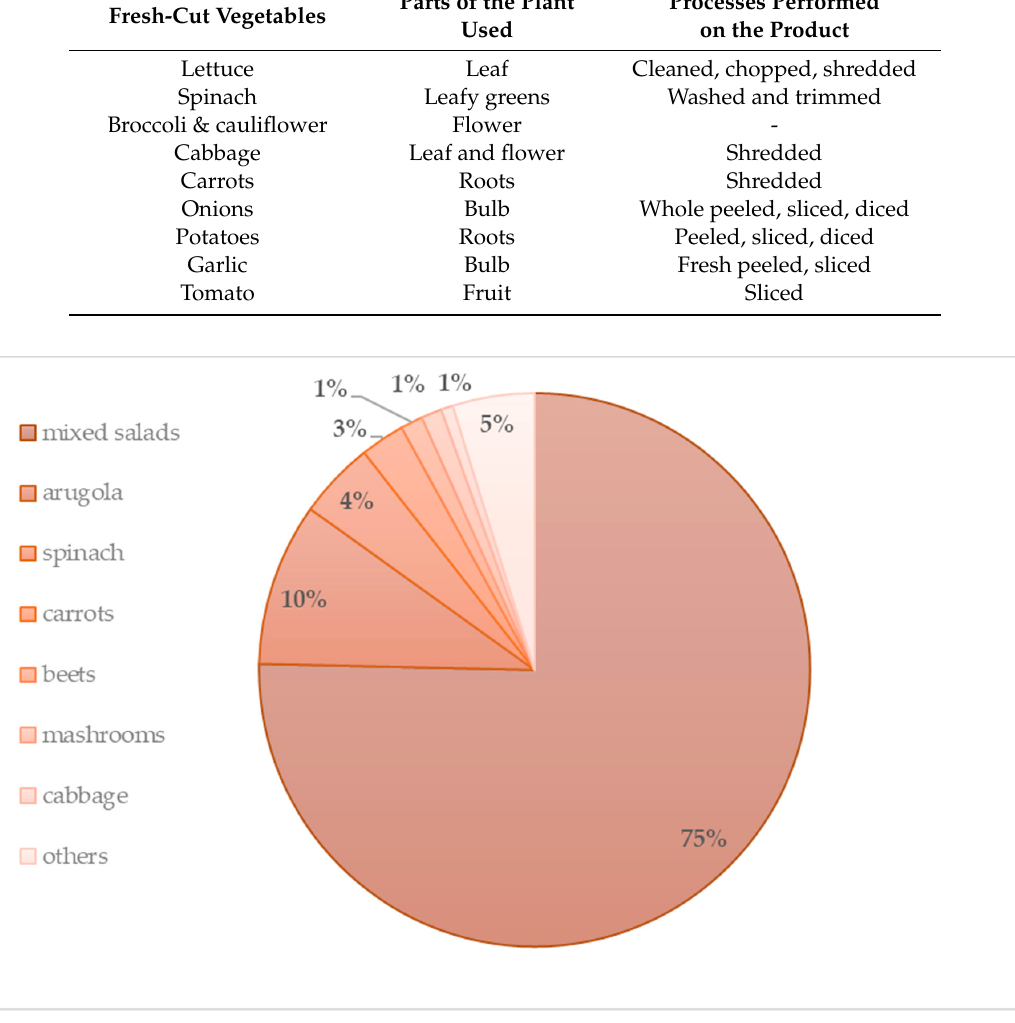
Table 1. Fresh-cut vegetable products: parts of the plants and processes performed on the products. Fresh-Cut Vegetables